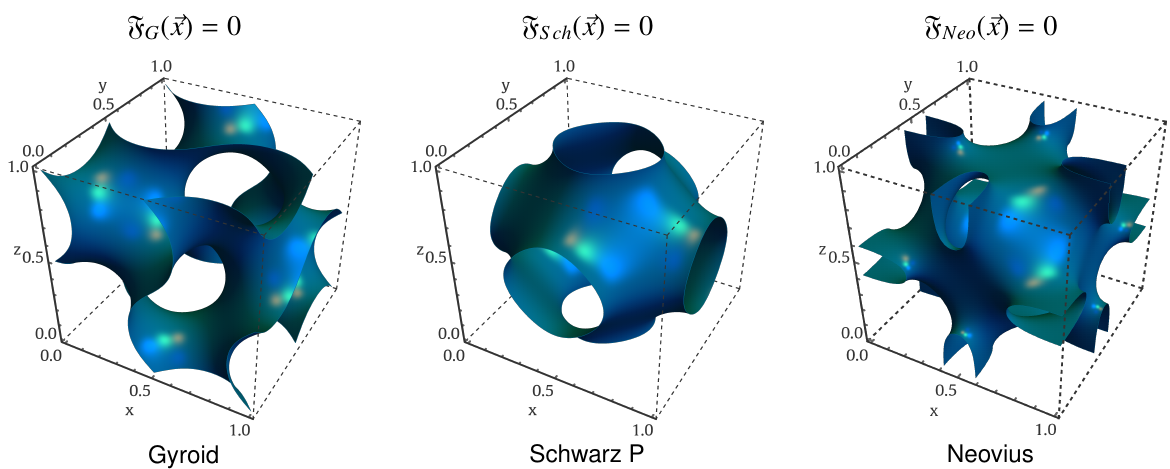
Figure 1. The original Gyroid, Shwarz P, and Neovius zero thickness surfaces, respectively, F G ( (cid:126) x ) = 0, F Sch ( (cid:126) x ) = 0, and F Neo ( (cid:126) x ) = 0. Only one cell is considered here: (cid:126) x ∈ [ 0,1 ] × [ 0,1 ] × [ 0,1 ] .